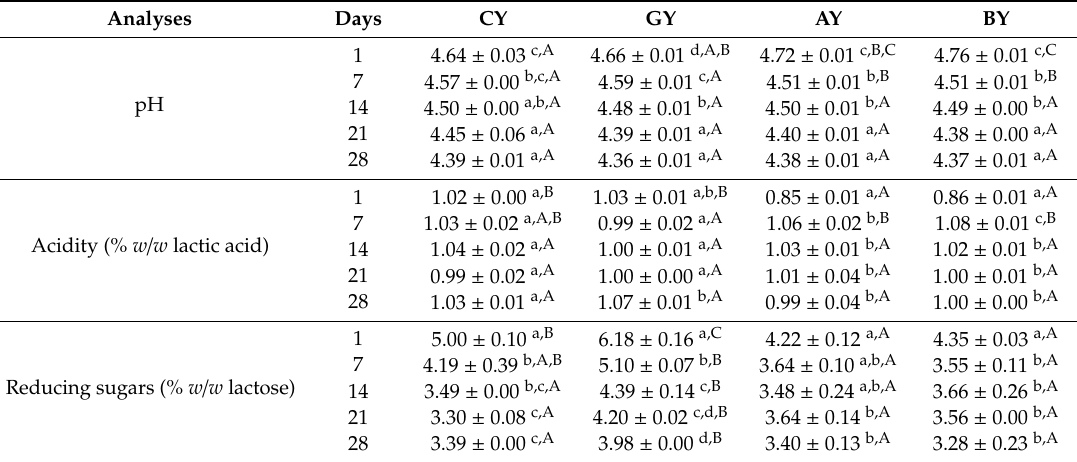
Table 1. E ff ect of storage on pH values, acidity, and reducing sugars of